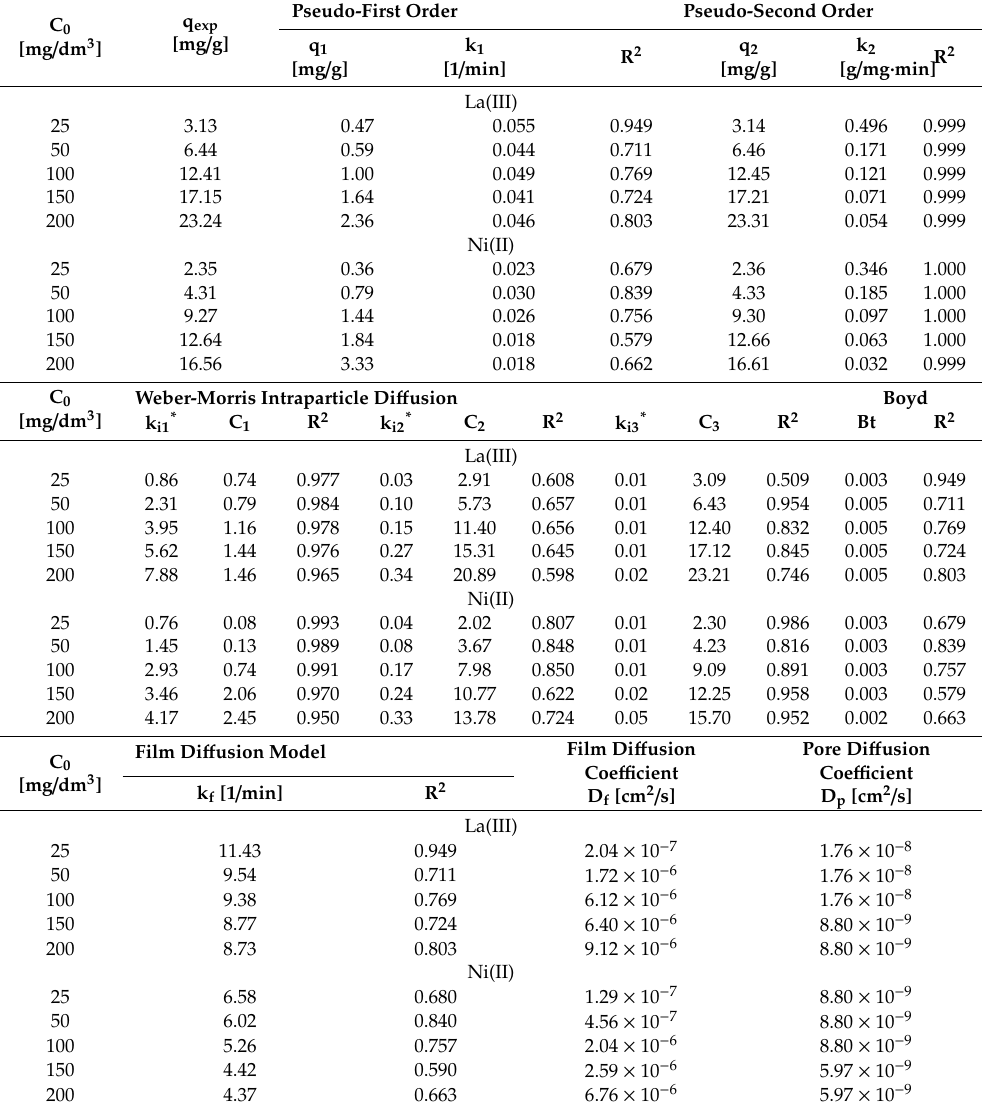
Table 2. Kinetic parameters for the La(III) and Ni(II) ions sorption on Lewatit Monoplus SP112. C 0 [mg / dm 3